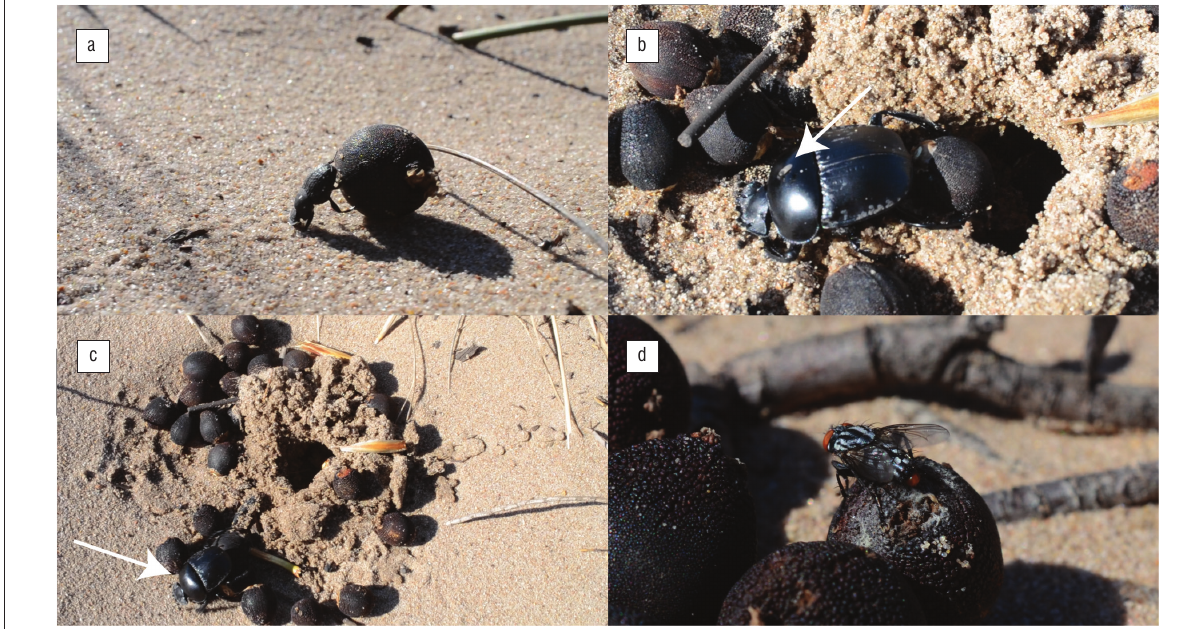
Figure 1: (a) Epirinus flagellatus rolling a Ceratocaryum argenteum seed; (b) Scarabaeus spretus rolling a seed (the arrow indicates a sphaerocerid lesser dung fly); (c) the large hole made by S. spretus for burying several seeds (the arrow indicates the location of the dung beetle); and (d) a female sarcophagid fly on a